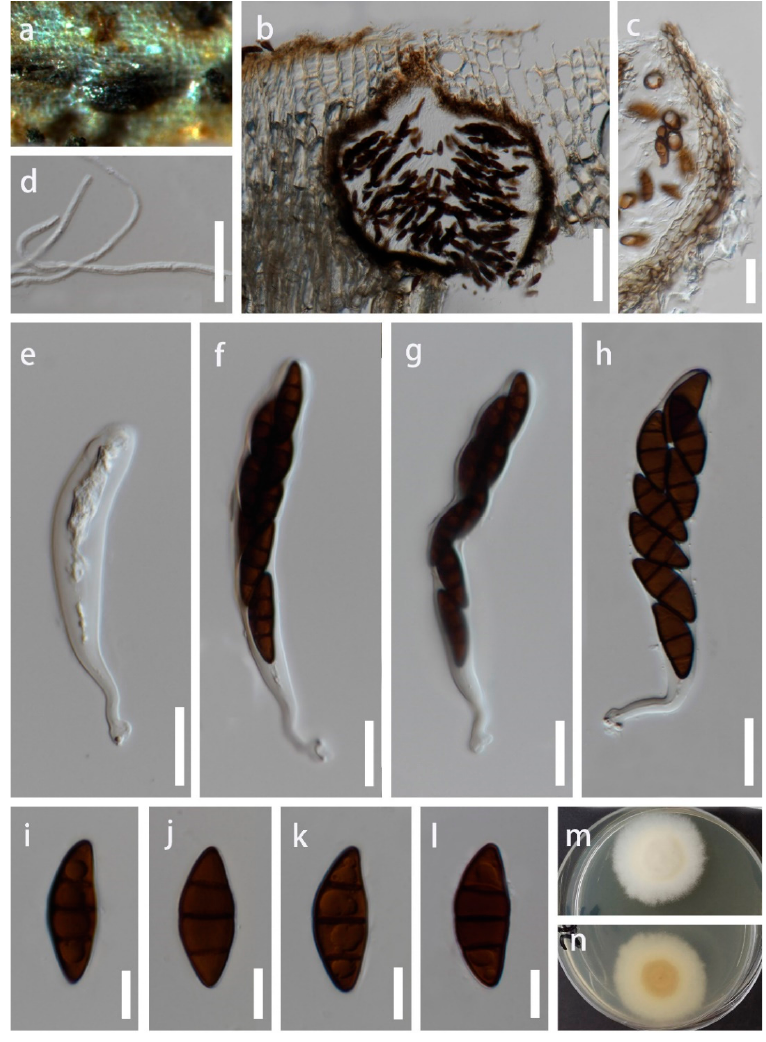
Figure 2. Montagnula aquatica (MFLU 22–0171, holotype). ( a ) Appearance of ascomata on the substrate, ( b ) Section through ascomata, ( c ) Peridium, ( d ) Trabeculate pseudoparaphyses, ( e – h ) Immature and mature asci, ( i – l ) Ascospores, ( m , n ) Colony on PDA medium. Scale bars: ( b ) = 100 µ m, ( c – h ) = 20 µ m, ( i – l ) = 10 µ